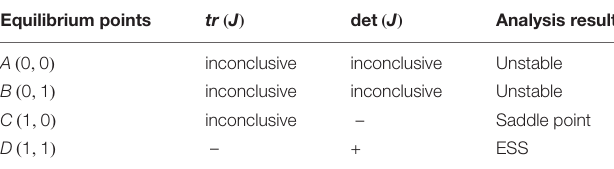
TABLE 8 | Local equilibrium stability analysis in case 4.